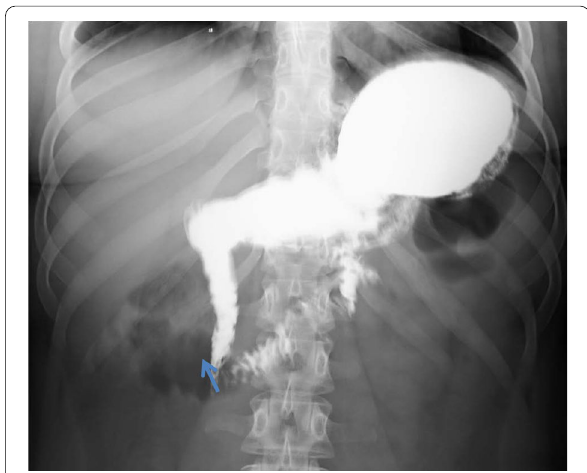
Fig. 2 Barium follow through shows extrinsic compression of the third part of the duodenum by a vertical band (arrow) with dilated stomach and second part of